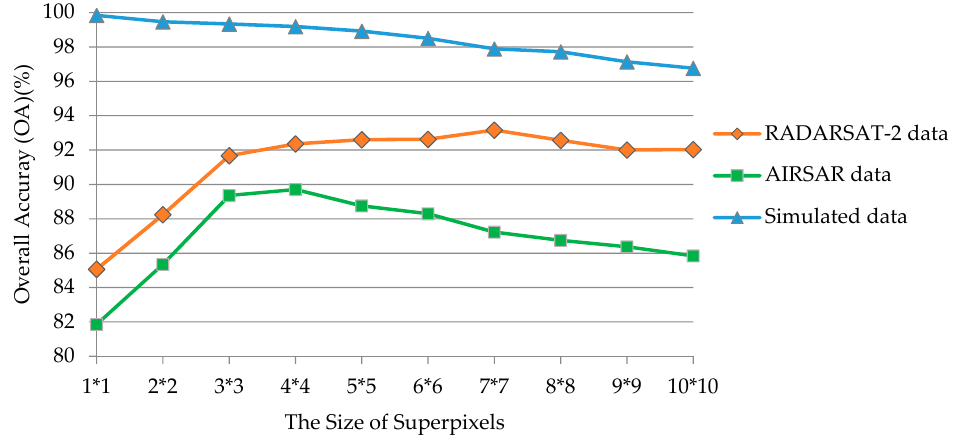
Figure 11. OA obtained by applying SP-KSEM-PLR to the simulated, RADARSAT-2 and AIRSAR images using different sizes of superpixels. Remote Sens. 2016 , 8 , 619